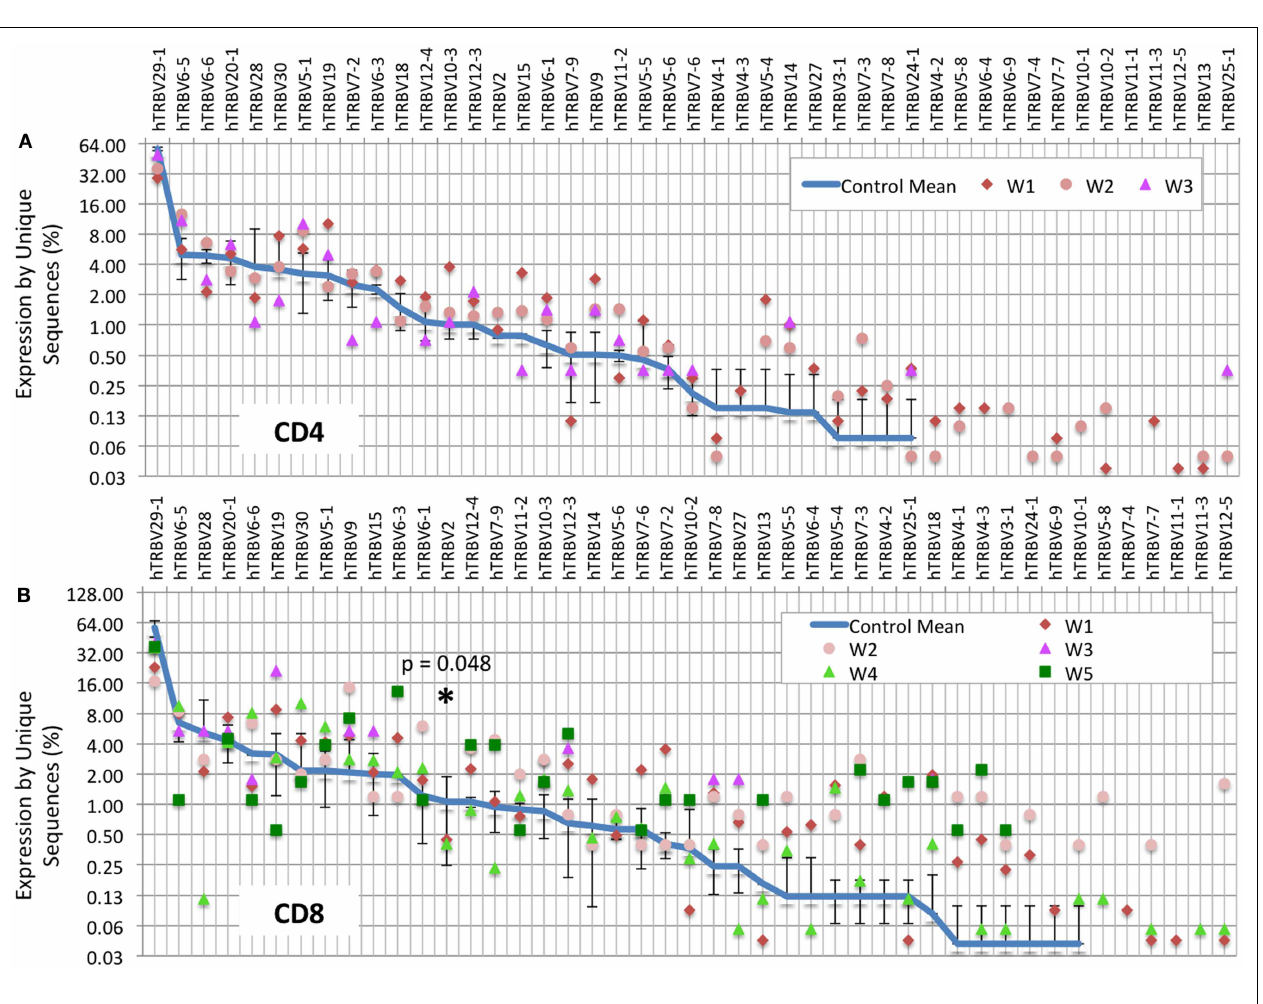
two control subjects, and the error bars indicate the SD of the frequency of the controls. p Values were calculated using Mann–Whitney test between controls andWAS for eachV segment. * p <